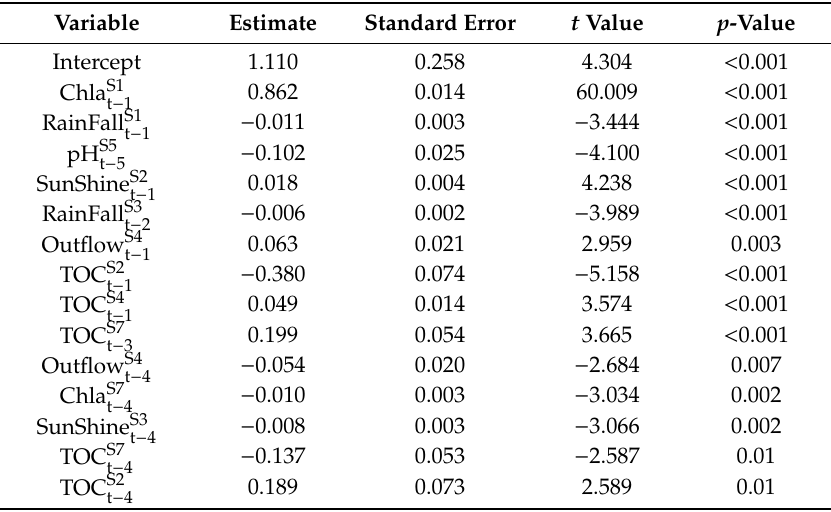
Table 2. Variables selected as a result of forward selection. Variable Estimate Standard Error